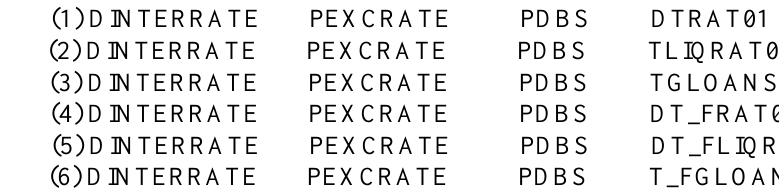
Table 1. Lag Length Selected by Information Criterion for